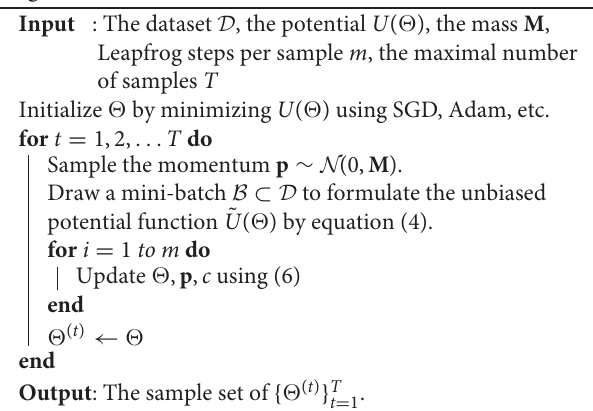
Algorithm 1: SGHMC with thermostats Algorithm 2: